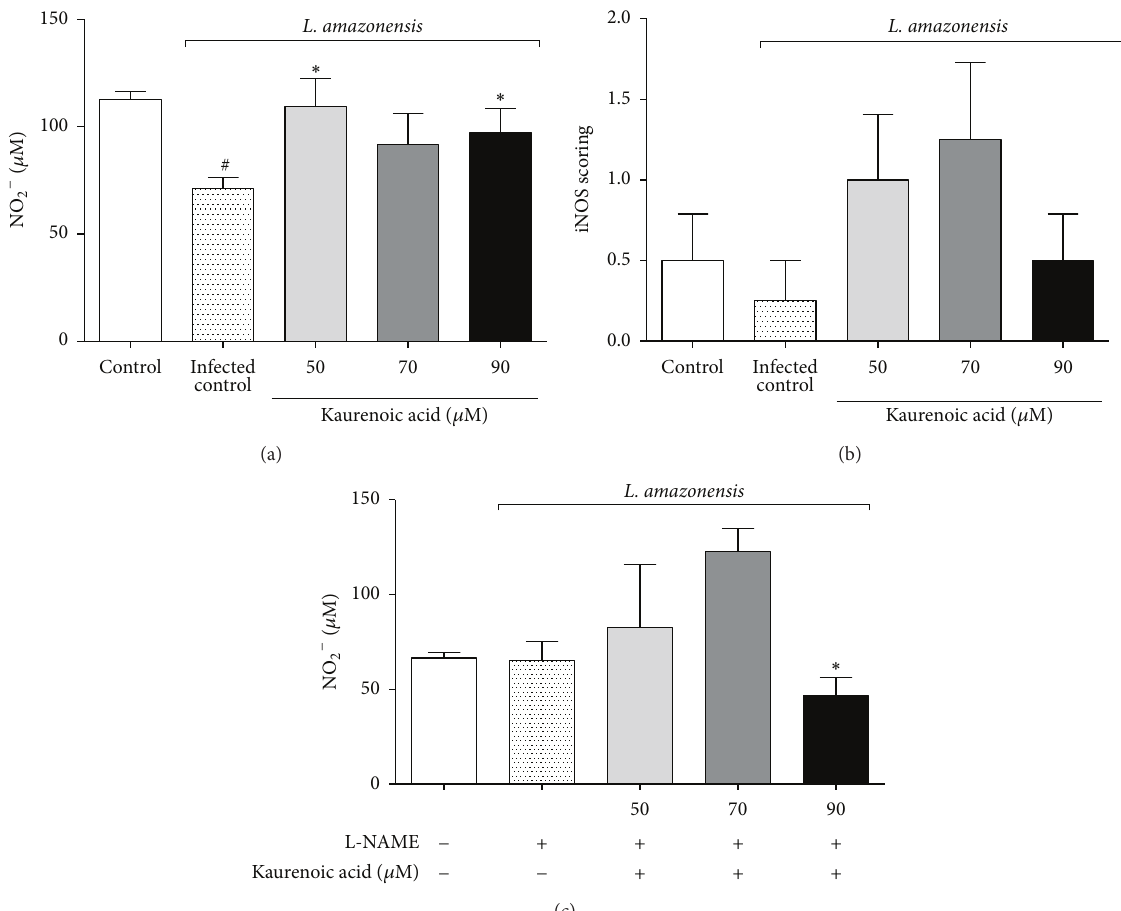
Figure 3: Kaurenoic acid exerted its effect by upregulating NO levels in a cNOS-dependent mechanism. NO levels (Panel (a)); immunocy- tochemistry scoring for inducible nitric oxide synthase (iNOS). Peritoneal macrophages infected with L. amazonensis and treated with kaurenoic acid (50, 70, and 90 𝜇 M) for 24 h (Panel (b)). Determination of NO in peritoneal macrophages infected with L. amazonensis and blocked with 20 𝜇 M L-NAME and treated with kaurenoic acid (50, 70, and 90 𝜇 M) for 24 h (Panel (c)). Data represent the mean ± SEM of three independent experiments. ( ∗ Significantly different from infected cells ( 𝑃 < 0.05 ). # Significantly different from control cells ( 𝑃 < 0.05 ) (one-way ANOVA followed by Tukey’s